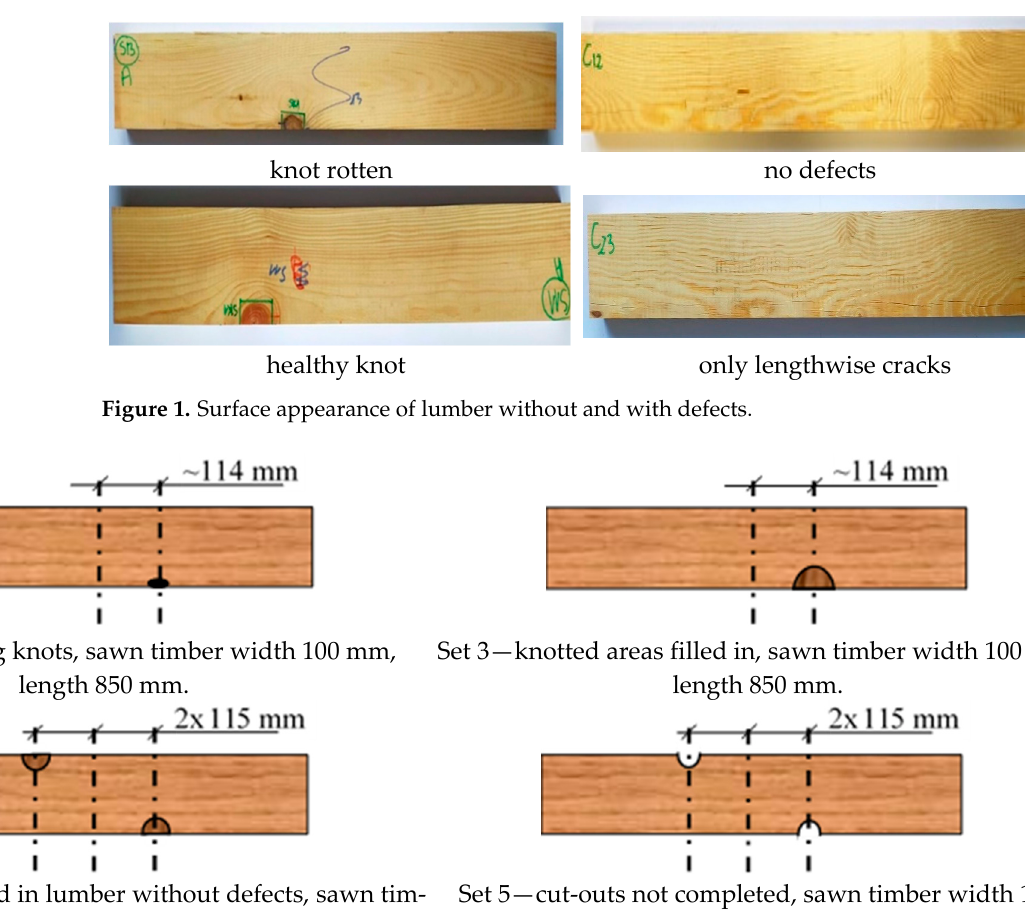
Figure 2. Schematics for the analysed sets.